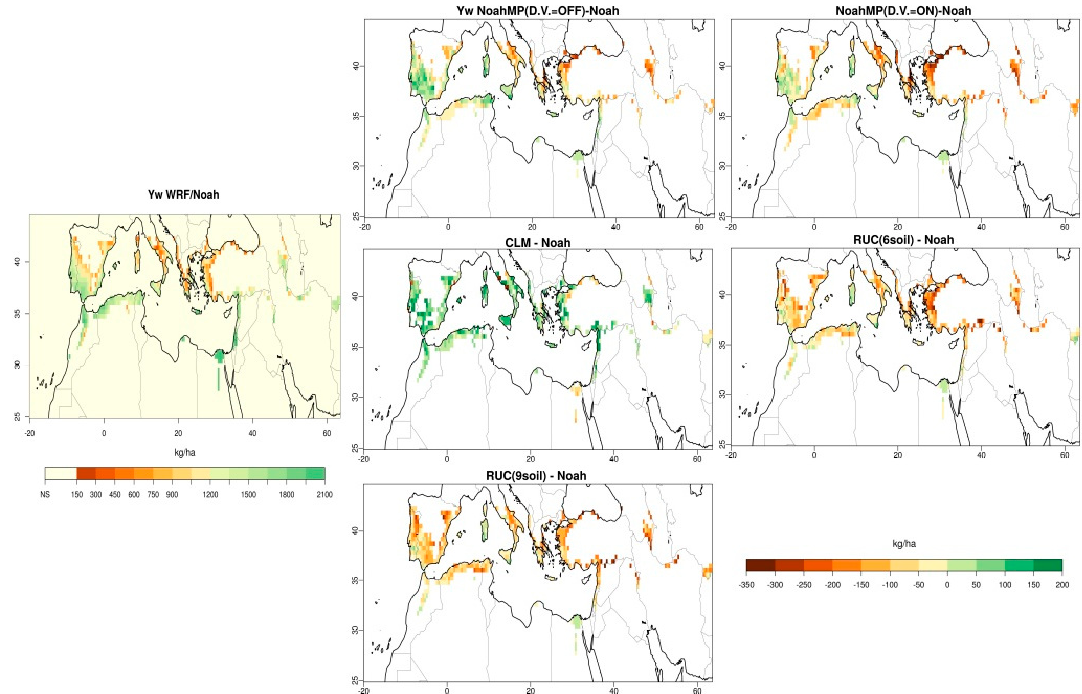
Figure 6. Water-limited yield (Yw) for durum (winter) wheat for the growing period of 1 st November–30 th April averaged for 2000–2010 by Noah (on the right-hand side) and the differences of Yw by NoahMP dyn. Veg.= OFF & ON, CLM and RUC 6 and 9 soil layers from Noah. Mean values of Yw of the above-mentioned cultivar over the different sub-regions in the Table 4. Mean values of Yw for durum wheat derived from the six experiments, the difference ( Δ ) of each run from the overall mean value, two times standard deviation and the “relative dispersion” for the six sub-domains (Anatolia, Balkans, western, central & eastern Mediterranean and Mesopotamia) and the reduced MENA domain.